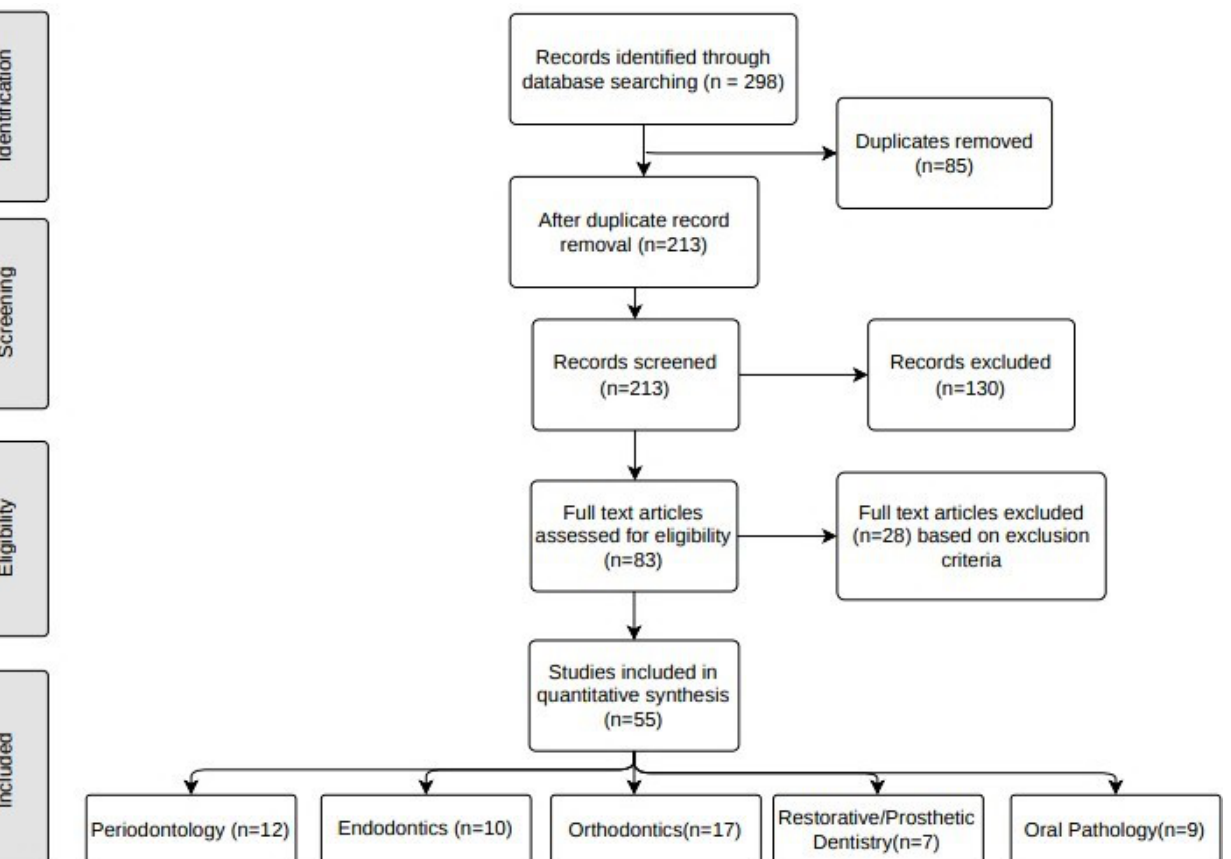
Figure 1. Relevant data about studies included for